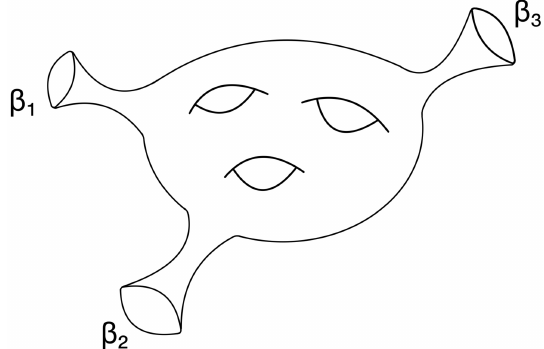
Figure 2. To merely illustrate the setup, we have drawn a genus-three Riemann surface with three boundary components, each of which is a circle of circumference β scalar curvature − 2 . Here we restrict only to the genus-zero